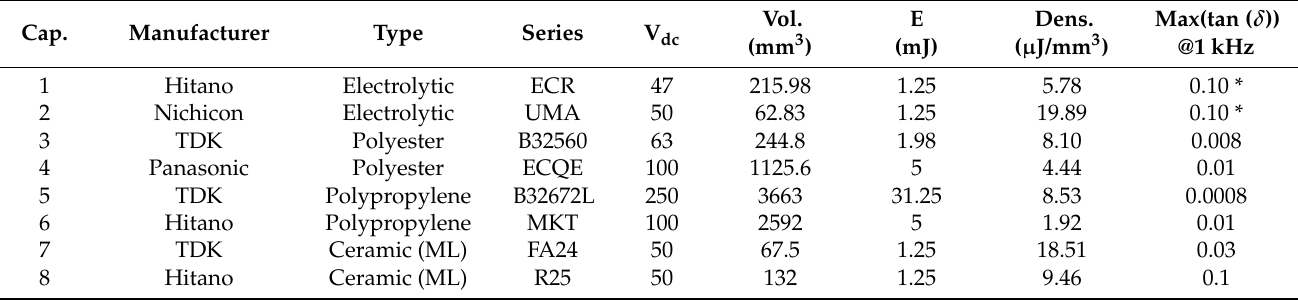
Table 3. Comparison among different types of capacitors.